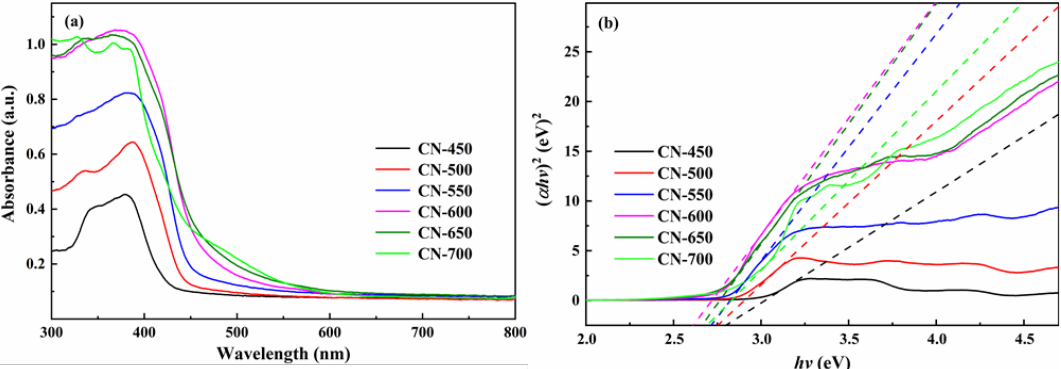
Figure 9. ( a ) UV-vis DRS spectra, and ( b ) the corresponding banding energy gap of samples.